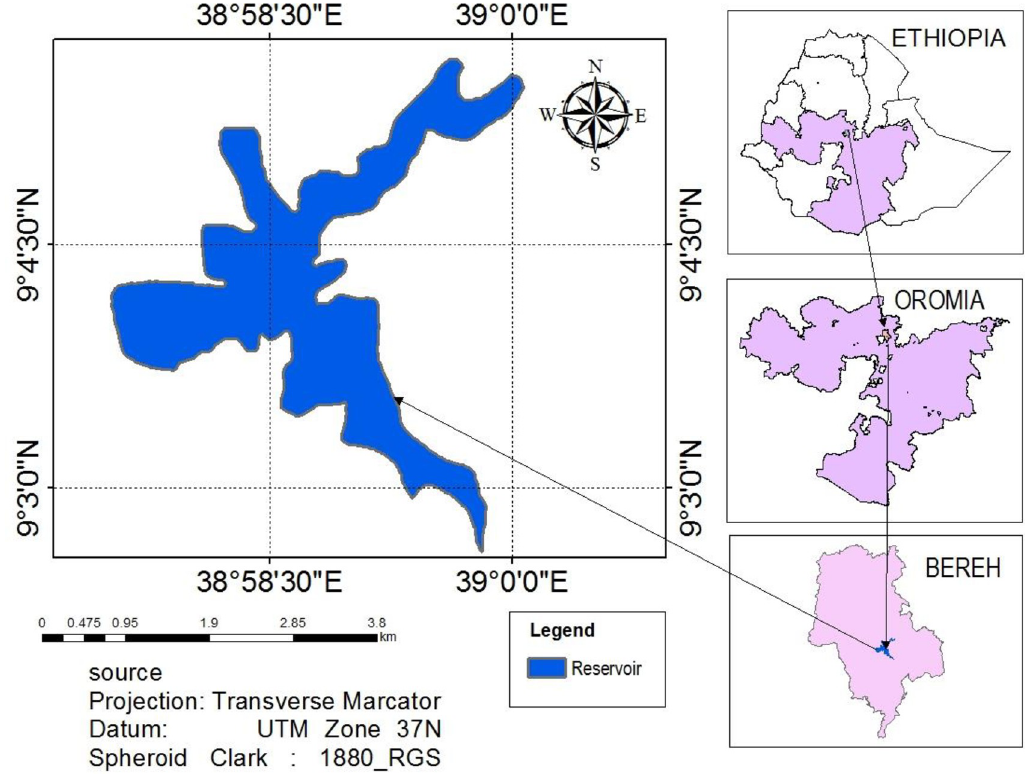
Fig 1. Map showing the location of the Legedadi